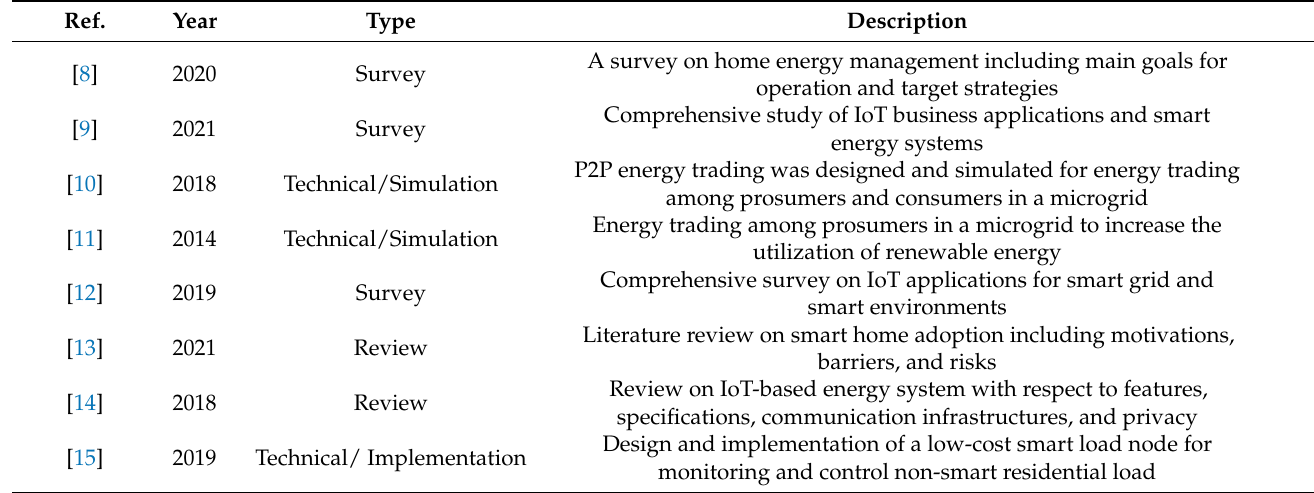
Table 1. Comparison among previous research